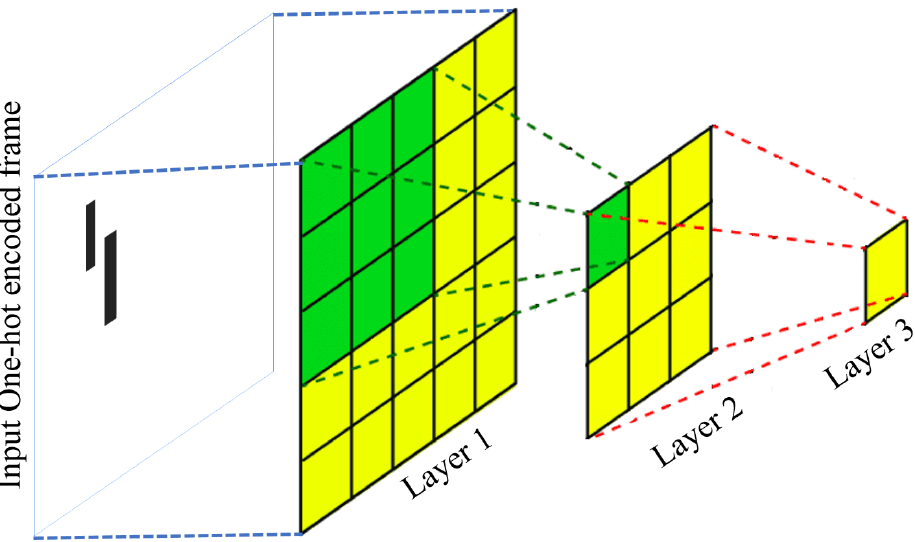
Figure 8. A very small region (yellow) in layer 3 represents a large receptive field (yellow and green grids of layer 1), resulting in loss of spatial information. Moreover, the bigger receptive field in layer 1 (yellow and green) represents more contextual information, which negatively affect the tailing detection performance as discussed in Section